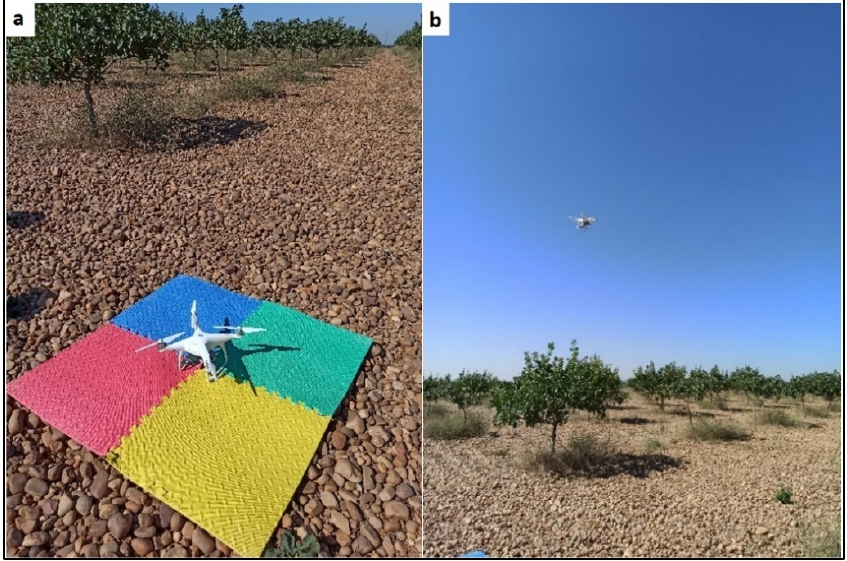
Figure 5. ( a ) DJI Phantom 4 Unmanned Aerial Vehicle (UAV), ( b ) UAV flight over the pistachio